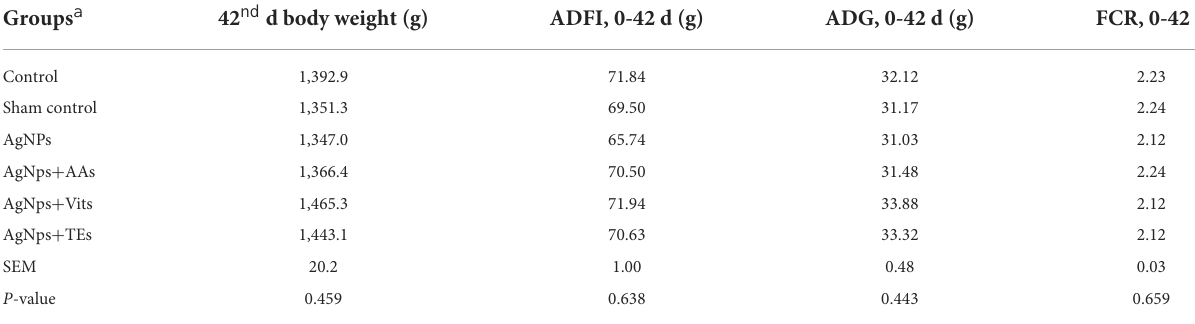
TABLE 2 Effect of in ovo administration of silver nanoparticles (AgNPs) and critical nutrients on performance of vaccinated birds. Groups a